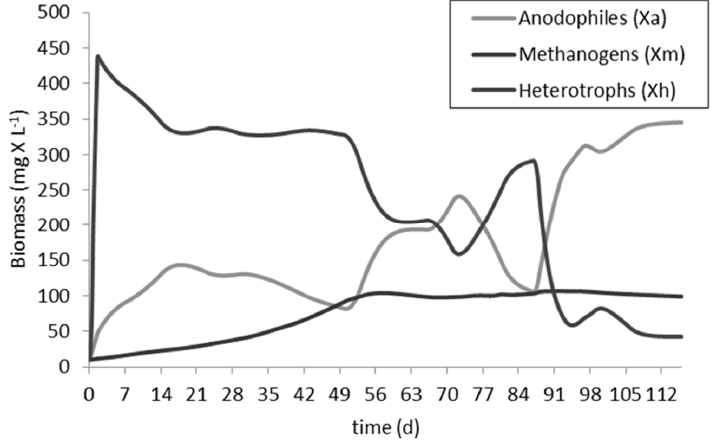
Figure 4. Predicted development of microbial populations in time.